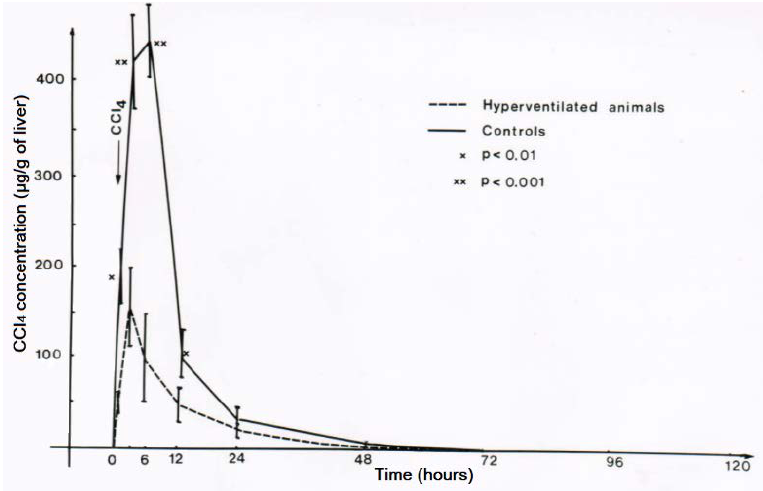
Figure 16. Experimental hyperventilation reduces CCl 4 levels in the liver, reproduced with permission from [43]. Copyright Springer, 1983. Toxics 2018 , 6 , x FOR PEER REVIEW